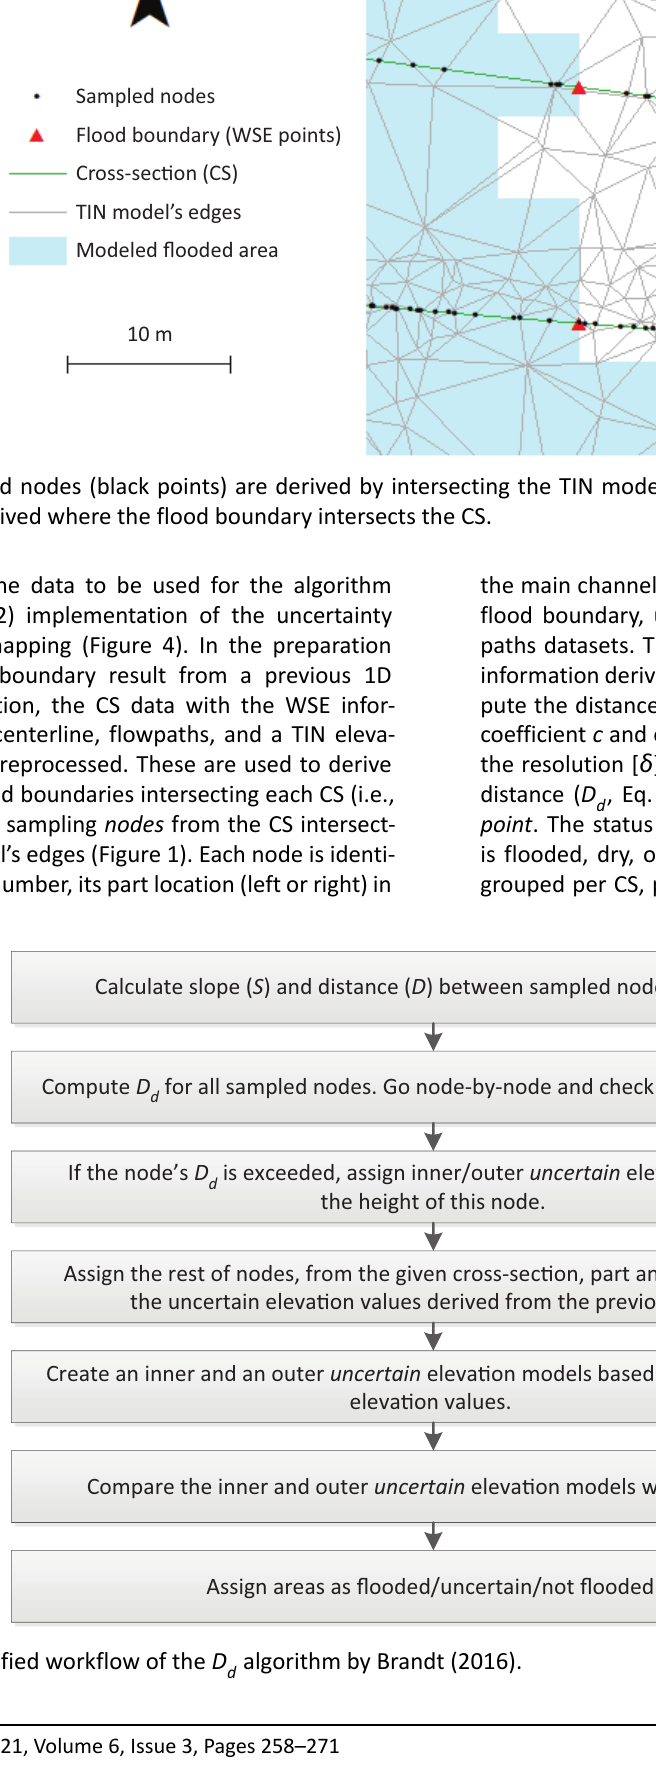
algorithm by Brandt d